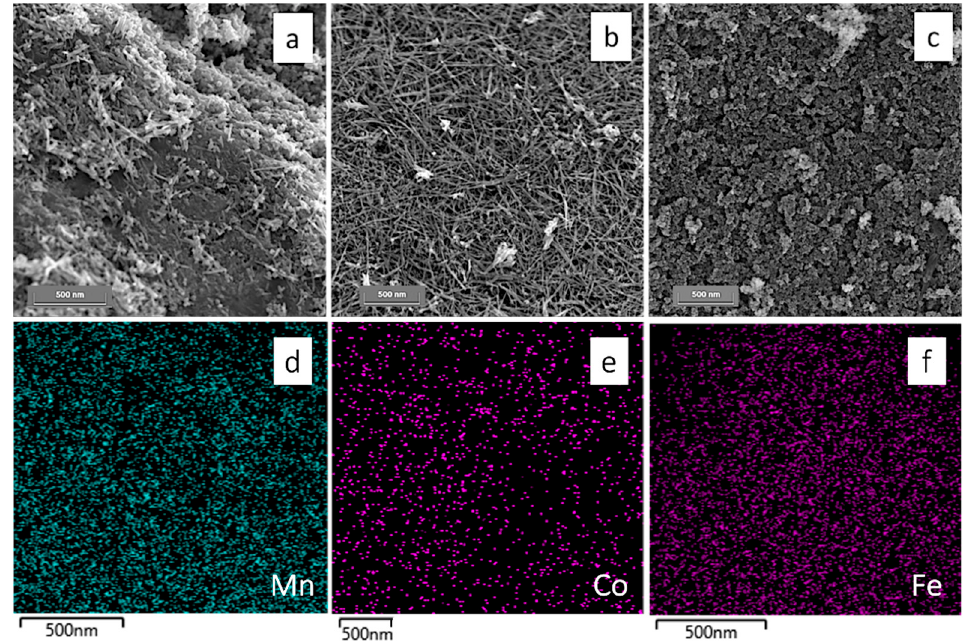
Figure 3. FEG-SEM images of ( a ) bare MnO 2 , ( b ) 5Co_MnO 2 and ( c ) 5Fe_MnO 2 . EDX mapping relative to ( d ) Mn, ( e ) Co in 5Co_MnO 2 and ( f ) Fe in 5Fe_MnO 2 samples.